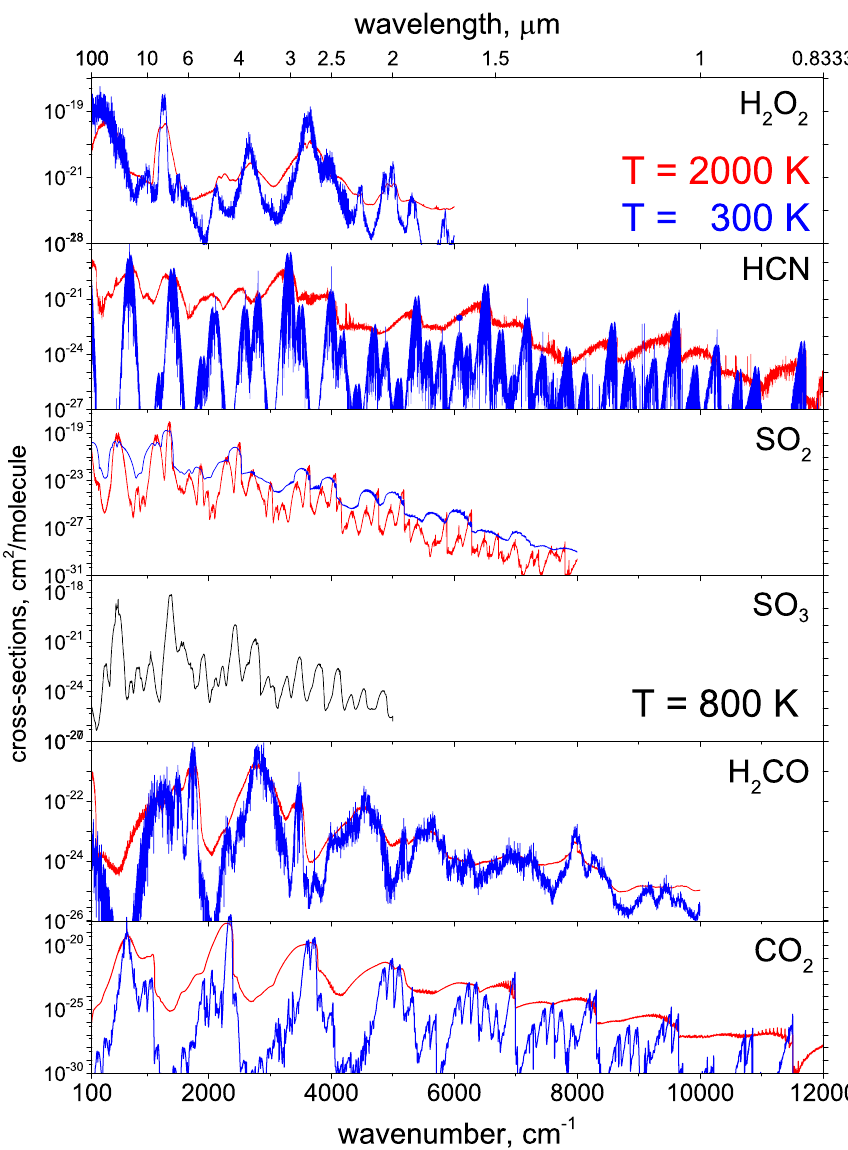
Figure 3. Cross sections for polyatomic oxides and HCN. Line lists are from ExoMol for hydrogen peroxide [109], hydrogen cyanide [30], sulfur dioxide [63], nitric aid [60] and sulfur trioxide [66]. The carbon dioxide data is taken from Ames-2016